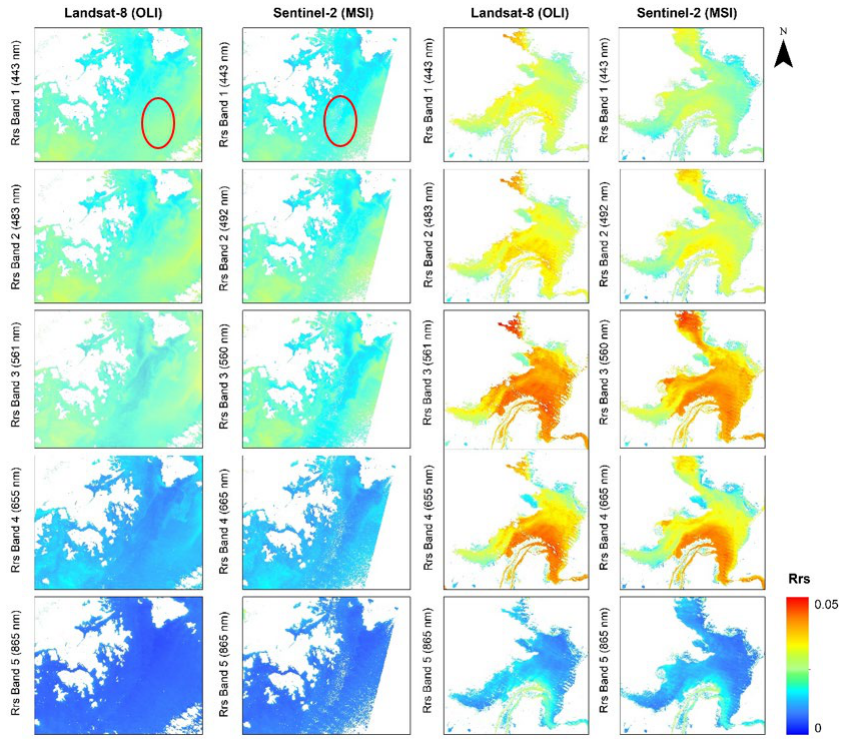
Figure 3. Pseudo-color maps of same-day Landsat-8 OLI and Sentinel-2 MSI-A water-leaving re- flectance ( R rs ). Two right columns show products over the eastern coastal area of Hong Kong (overpass on 16 December 2016) and two left columns show products over Lake Hongze, China (overpass on 9 October